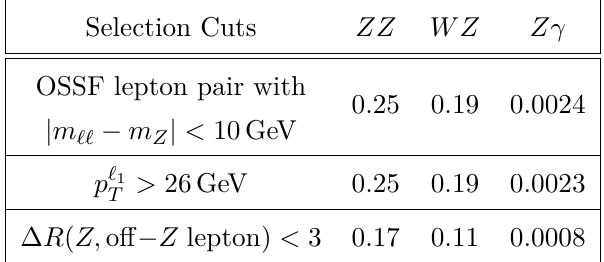
Table 1 . Cumulative efficiencies for the background events after applying the selection cuts √ corresponding to the analysis performed at s = 8 TeV . Efficiencies are presented as the number of events which are selected over the number of initial events. We have included in the generation only leptonic decays of the Z and W into electron, muons and taus but apply our cuts only to final state electrons and muons.